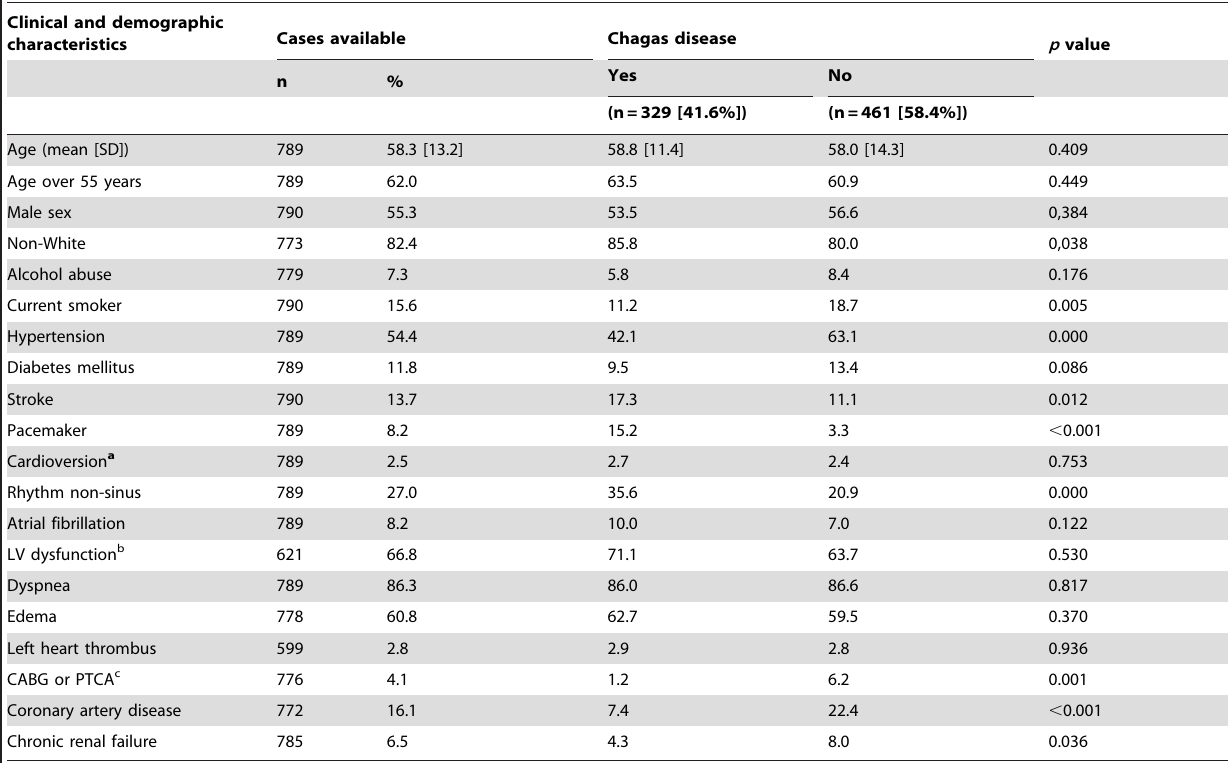
Table 1. Baseline Characteristics of 790 Cardiomyopathy Patients.